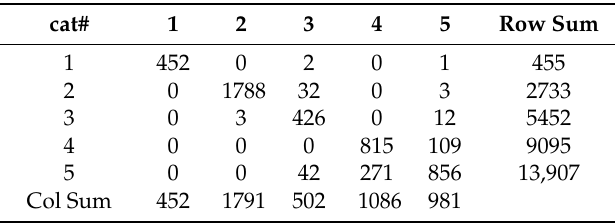
Table 3. An example of an error matrix.